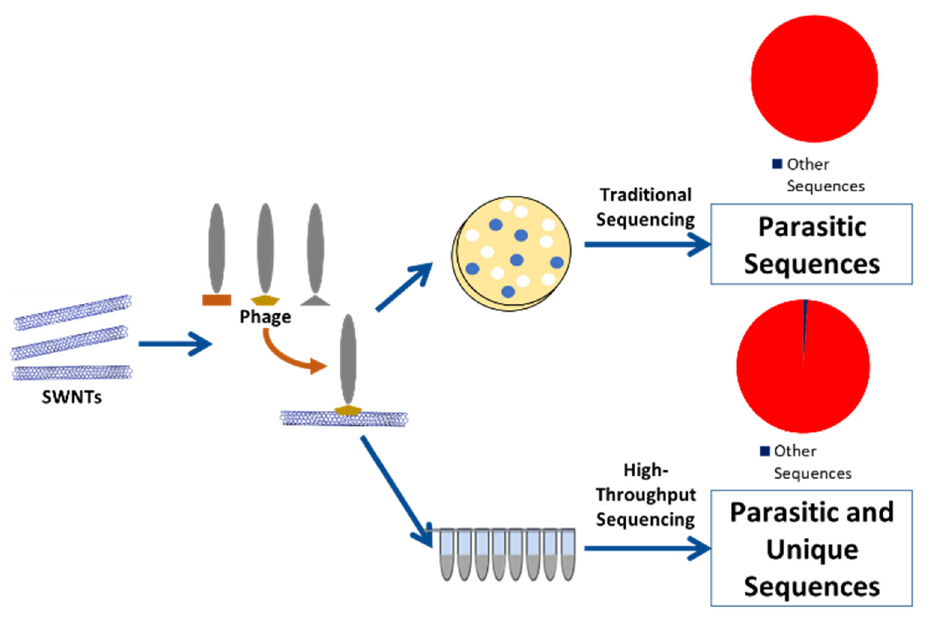
Figure 1. PD schematics showing the identification of binding peptides from both traditional and HTS–PD methods for SWNT target.